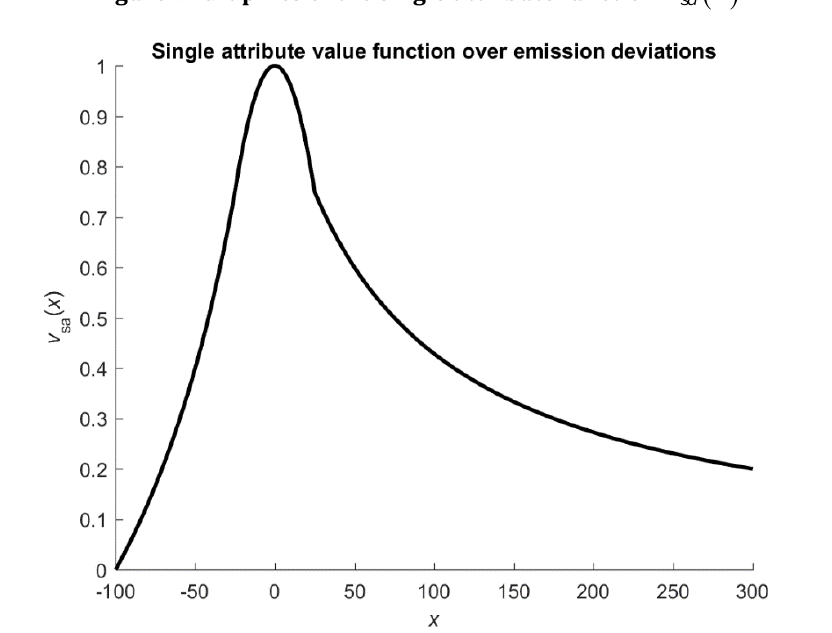
Figure 7: Graphics of the single attribute